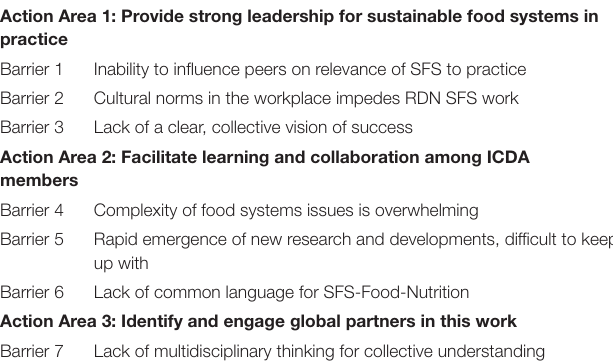
TABLE 1 | Actions for addressing barriers to integration of SFS work in dietetics practice. Action Area 1: Provide strong leadership for sustainable food systems in practice